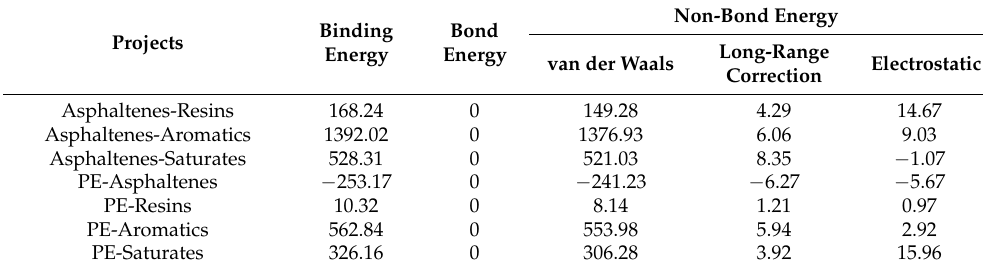
Table 5. Binding energy between components in CNT/RPE-modified